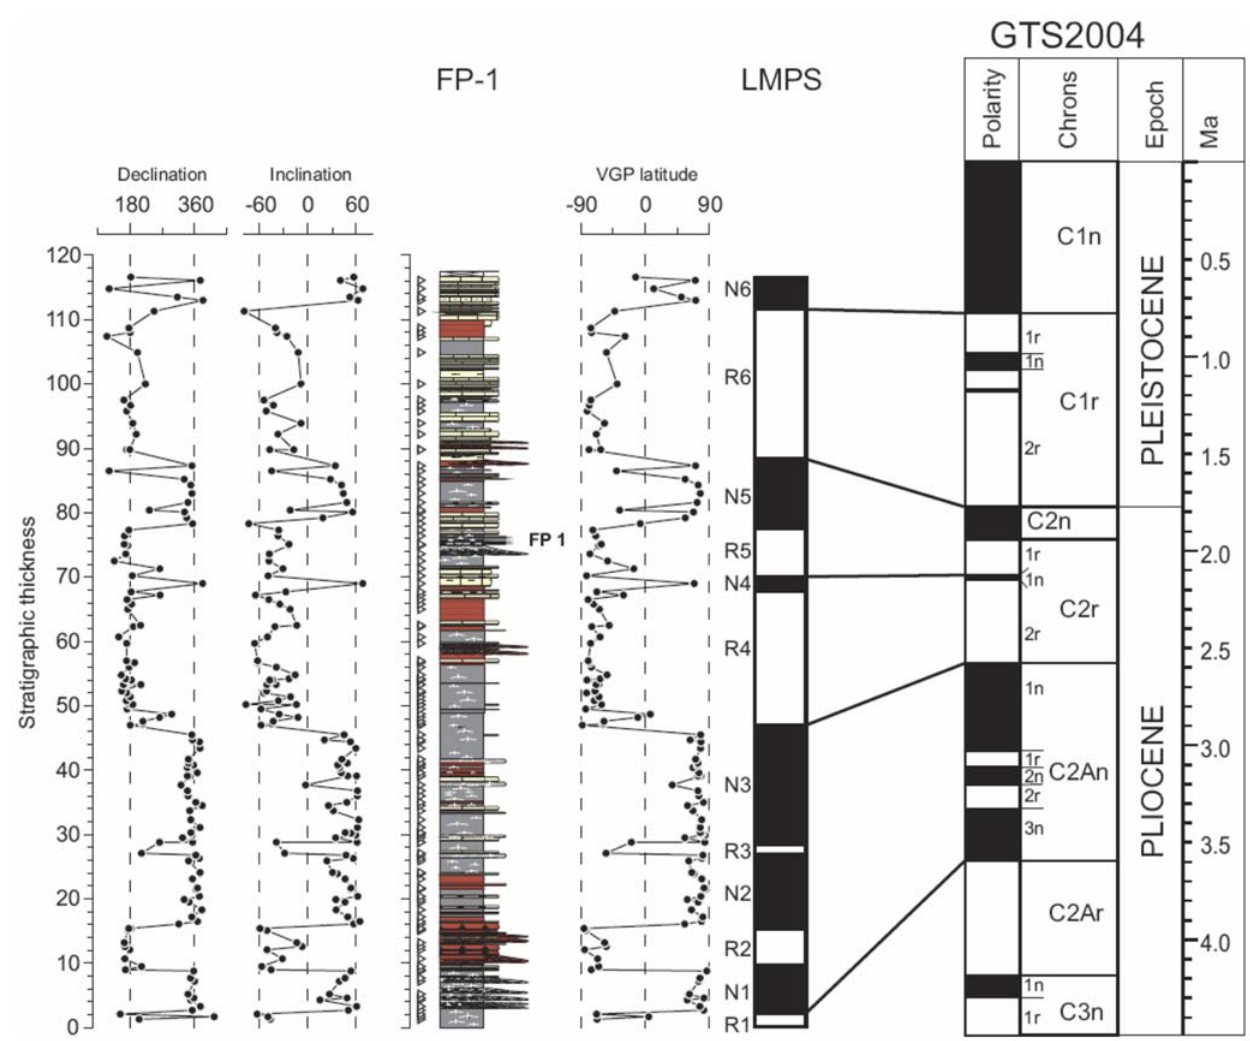
Figure 4. Magnetostratigraphy of the FP-1 section and correlation with the geomagnetic polarity time scale.